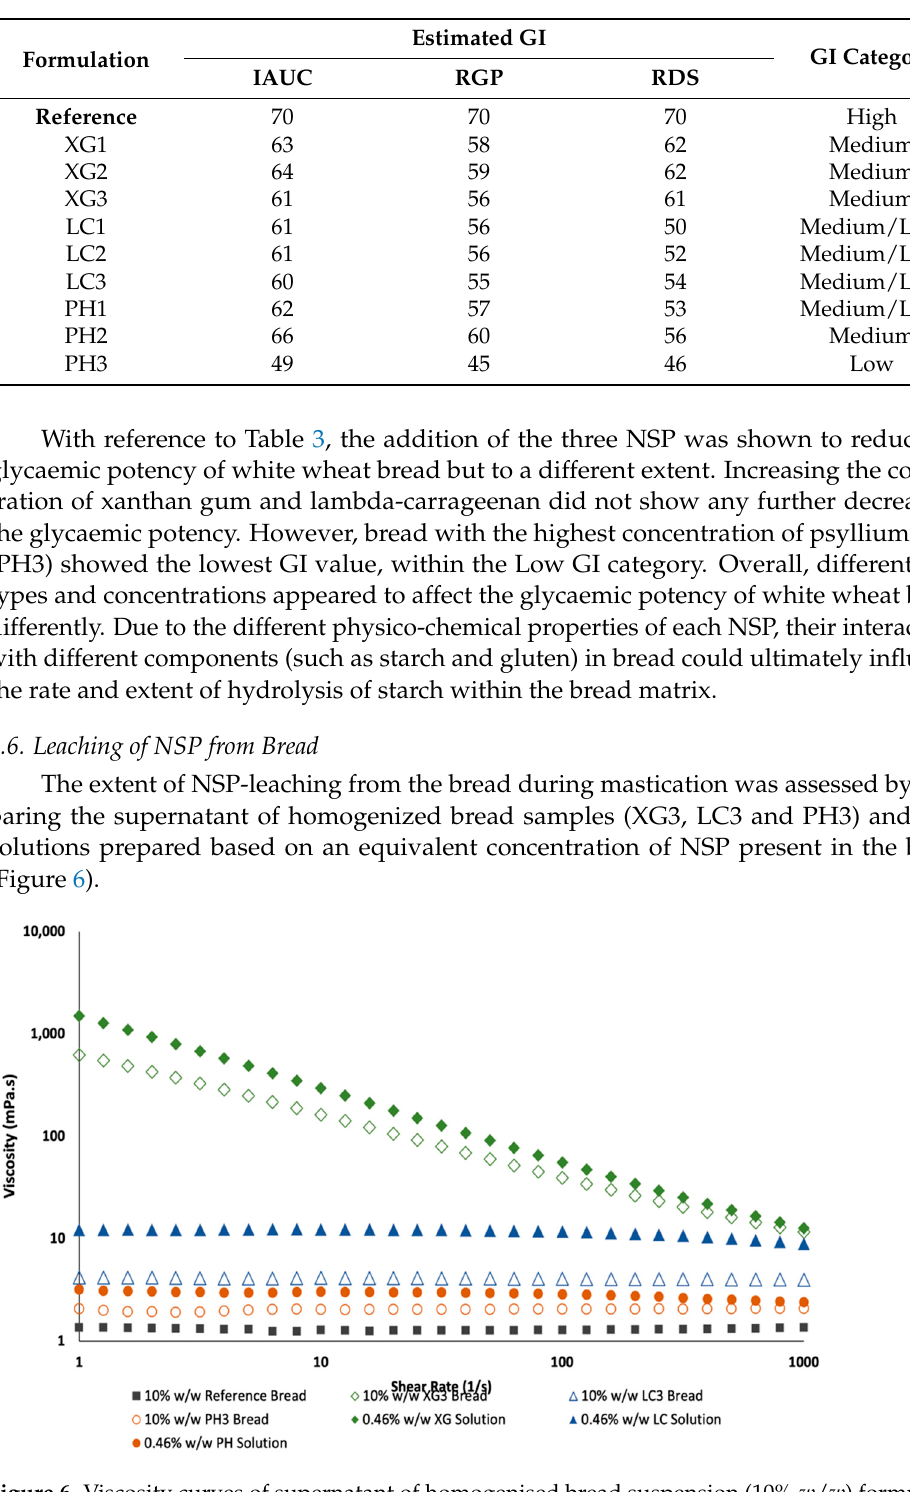
Figure 6. Viscosity curves of supernatant of homogenised bread suspension (10% w / w ) formulated with 5% w / w of soluble NSP and 0.46% w / w pure NSP solutions. XG, LC and PH denote xanthan gum, lambda-carrageenan and psyllium husk, respectively. Values are averages of duplicate meas- urements. The viscosity values of the supernatant solutions obtained from bread samples were lower than the pure respective NSP solutions but higher than the reference sample. This means that some leaching of NSPs from the homogenized bread had occurred. Among the bread samples, the viscosity at shear rates between 10 and 100 s − 1 , typical of shear rates in the gastrointestinal tract [39,40], showed that the bread containing xanthan gum can potentially form a higher chyme viscosity at least 10 times greater (based XG3 with ~60 mPa.s at 50 s − 1 ) than bread containing lambda-carrageenan (~4 mPa.s at 50 s − 1 ) or psyllium husk (~2 mPa.s at 50 s − 1 ). The higher chyme viscosity suggests that the incorporation of xanthan gum in bread formulation can potentially reduce the glycaemic potency. The ef- fect of viscosity in reducing glycaemic potency in white bread has been reported in vari- ous studies [15,20,41]. Compared to the reference bread, the addition of psyllium husk (PH3) or lambda- carrageenan (XG3) could be expected to have a low to negligible effect on the ‘chyme’ viscosity and both had viscosity values close to water. It is worth noting that psyllium husk consists of both soluble and insoluble polysaccharide fractions and most of the psyl- lium would remain entrapped within the solid fraction of the bread matrix. This could imply that the marked decrease in glycaemic potency with PH3 addition (Table 3) may not be attributed to the viscosity of leached polysaccharides. Instead, psyllium husk pos- sibly interacted with the bread matrix that was formed from gluten and gelatinised starch. In addition, as reported previously for xanthan, psyllium husk could restrict starch gelat- inization by coating the starch granules or/and affecting amylose interactions in the final network [42]. The distribution of psyllium husk at sufficient concentrations within the bread matrix could then hinder enzymes from rapidly hydrolysing starch distributed in the bread structure during the in vitro digestion process, yielding bread with low GI val- ues. The effectiveness of psyllium in lowering GI has also been reported in gluten-free bread formulation [26]. Other possible effects, such as the direct inhibition of enzyme ac- tivity reported in the case of guar gum [43], cannot be ruled out at this stage and would require further validation in future studies. All these possible mechanisms involving NSP can potentially aid in slowing postprandial blood glucose response [39].